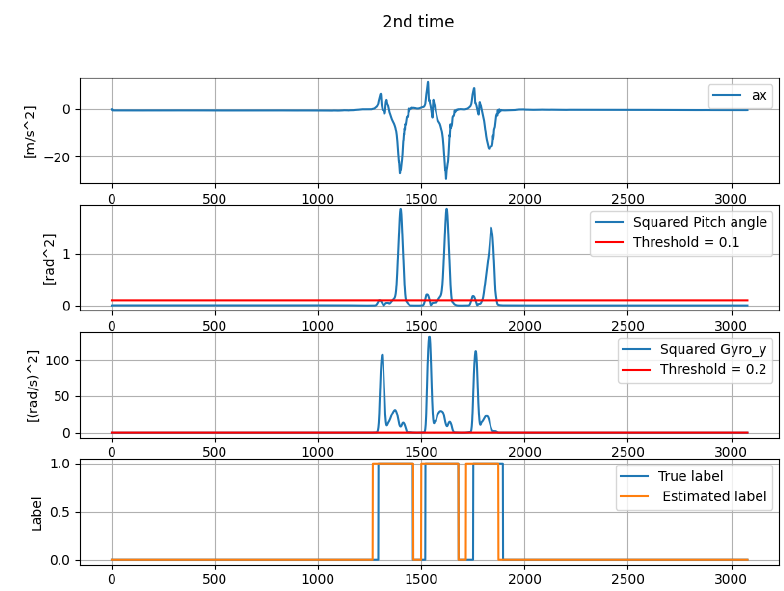
Figure 11. The wave-form of the data from the second data collection.